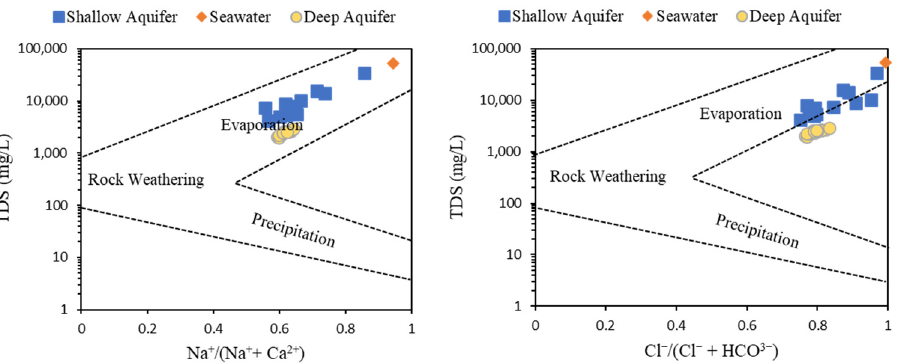
Figure 9. Gibbs plot of the GW samples from shallow and deep aquifers with seawater